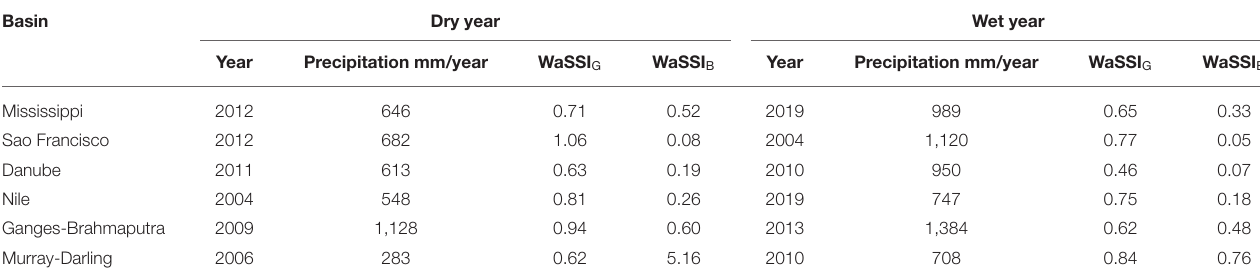
TABLE 3 | Summary of green (WaSSI G ) and blue (WaSSI B ) water supply stress indices during dry and wet years across study basins.